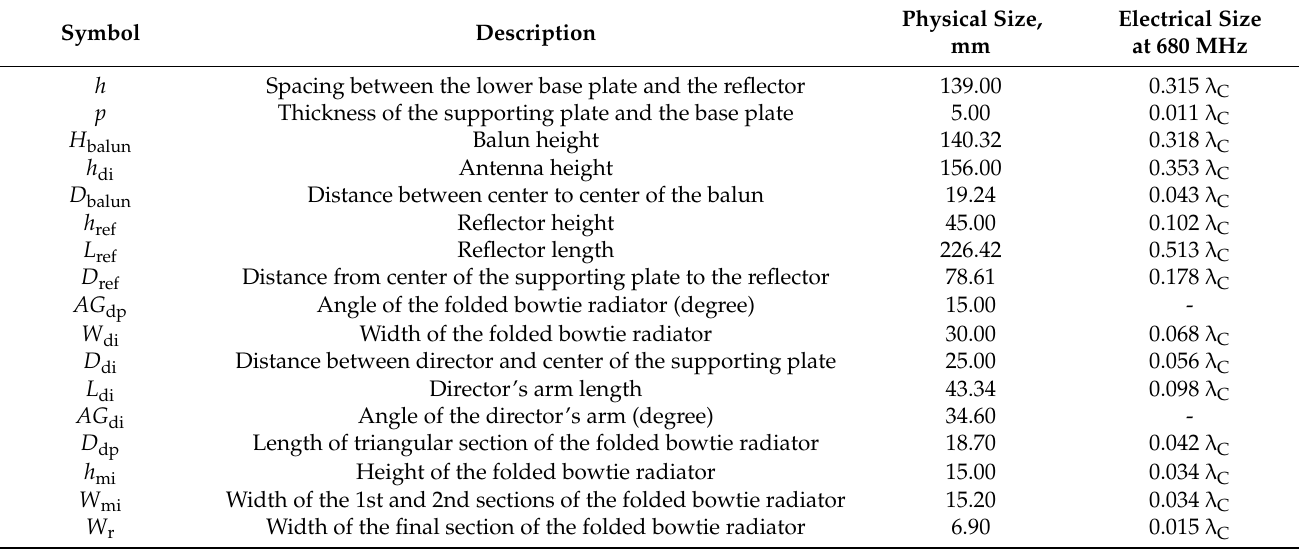
Table 1. The optimal dimensions of the portable wideband directional antenna for digital terrestrial television